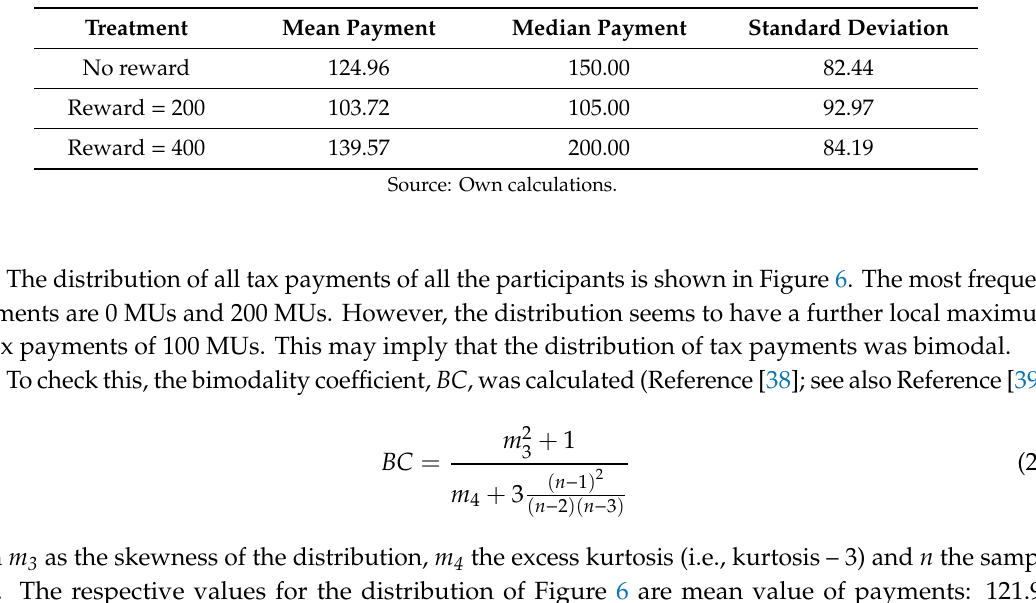
Table 1. Mean and median tax payments according to